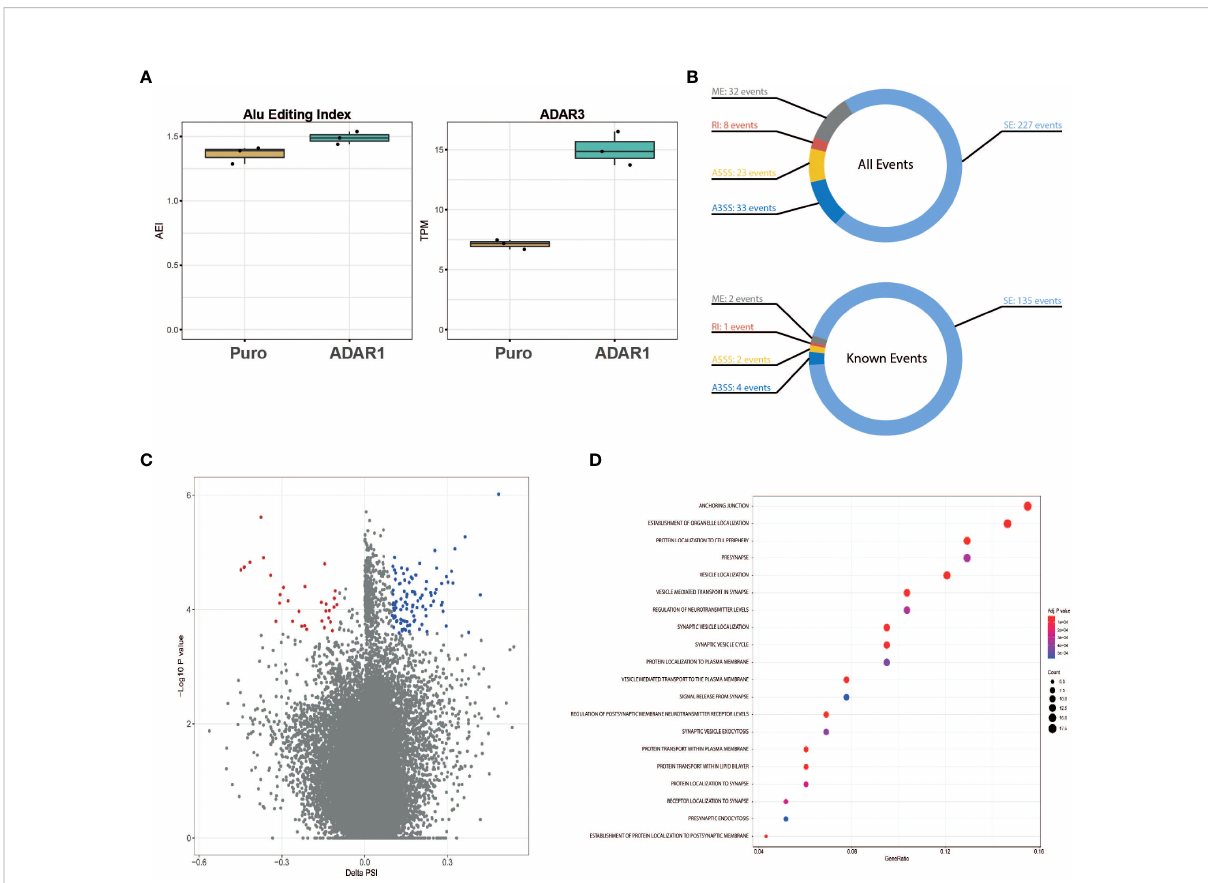
FIGURE 5 ADAR1 overexpression triggers alternative splicing in EndoC- b H1. (A) Global A-to-I RNA editing index across Alu elements (short interspersed nuclear elements) in Puro modi fi ed EndoC- b H1 and ADAR1 modi fi ed EndoC- b H1 cells (left panel), ADAR3 expression in Puro and ADAR1 modi fi ed EndoC- b H1. Data are shown as Transcript Per Million. (B) Donut charts representing the cumulated number of known and de novo alternative splicing events (top), and known events only (bottom). Events displayed have | D PSI| >0.10 and FDR <0.05. (C) Volcano plot of the inclusion and exclusion SE (skipped exon) events in EndoC- b h1 cells overexpressing ADAR1. Negative PSI indicates the inclusion of the event in ADAR1-overexpressing EndoC- b H1 cells whereas positive PSI indicates exclusion. Each dot represents an event with its D PSI (x-axis) associated to its P -value (y-axis). Colored dots (blue and red) represent genes with FDR<0.05. (D) Dot plot of the enrichment analysis, using Gene Ontology as reference, shows gene sets affected by known splicing events in cells overexpressing ADAR1. Gene ratio (x-axis) refers to the percentage of total genes input with alternative splicing events in selected GO terms (y-axis). SE, Spliced Exon; RI, Retain Intro; MXE, Mutually Exclusive Exon; A3SS, 3 ’ Alternative Splicing Site; A5SS, 5 ’ Alternative Splice